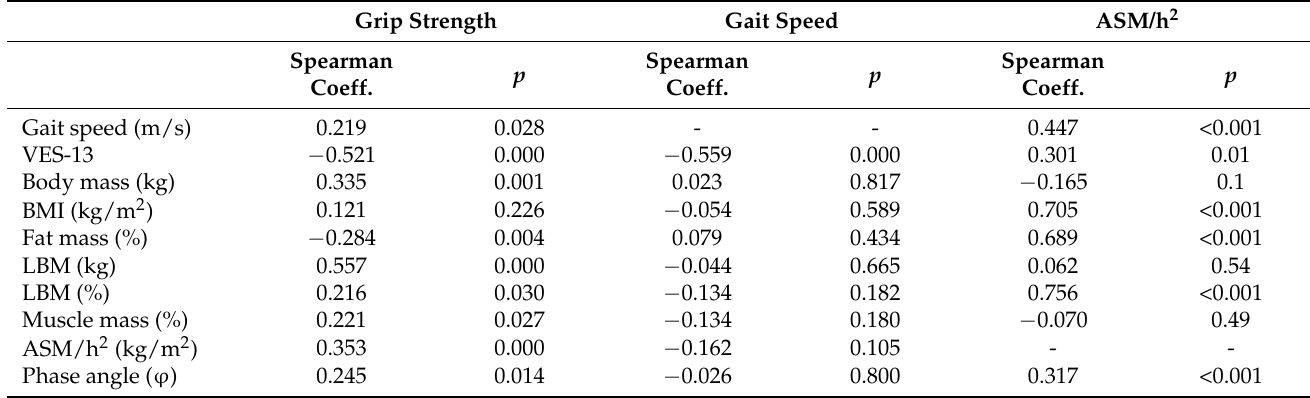
Table 6. Correlation of sarcopenia diagnostic criteria.